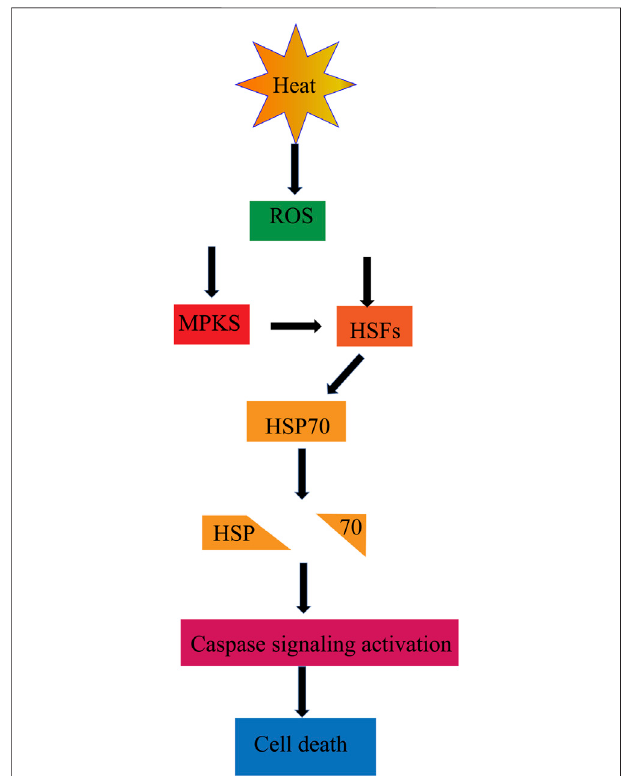
FIGURE 6 | ROS and HSPs. ROS produced by heat stress leads to changes in HSP related and